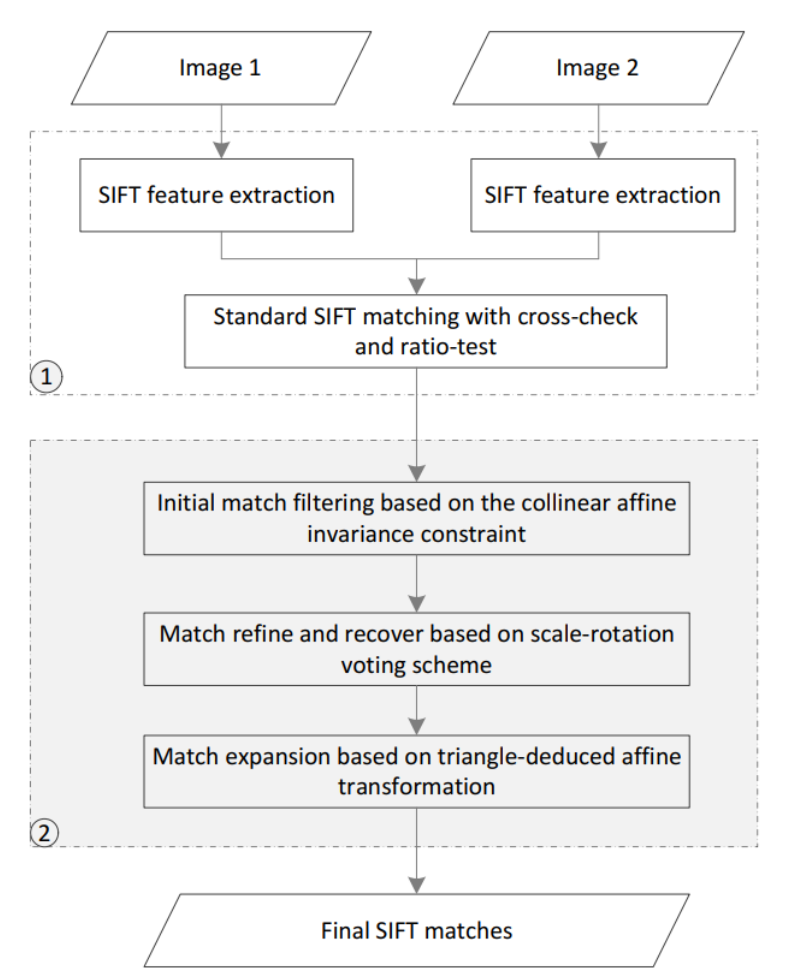
Figure 1. The workflow of the proposed outlier-removal algorithm. Step 1 is initial matching; step 2 is outlier removal based on the proposed CAISOV.